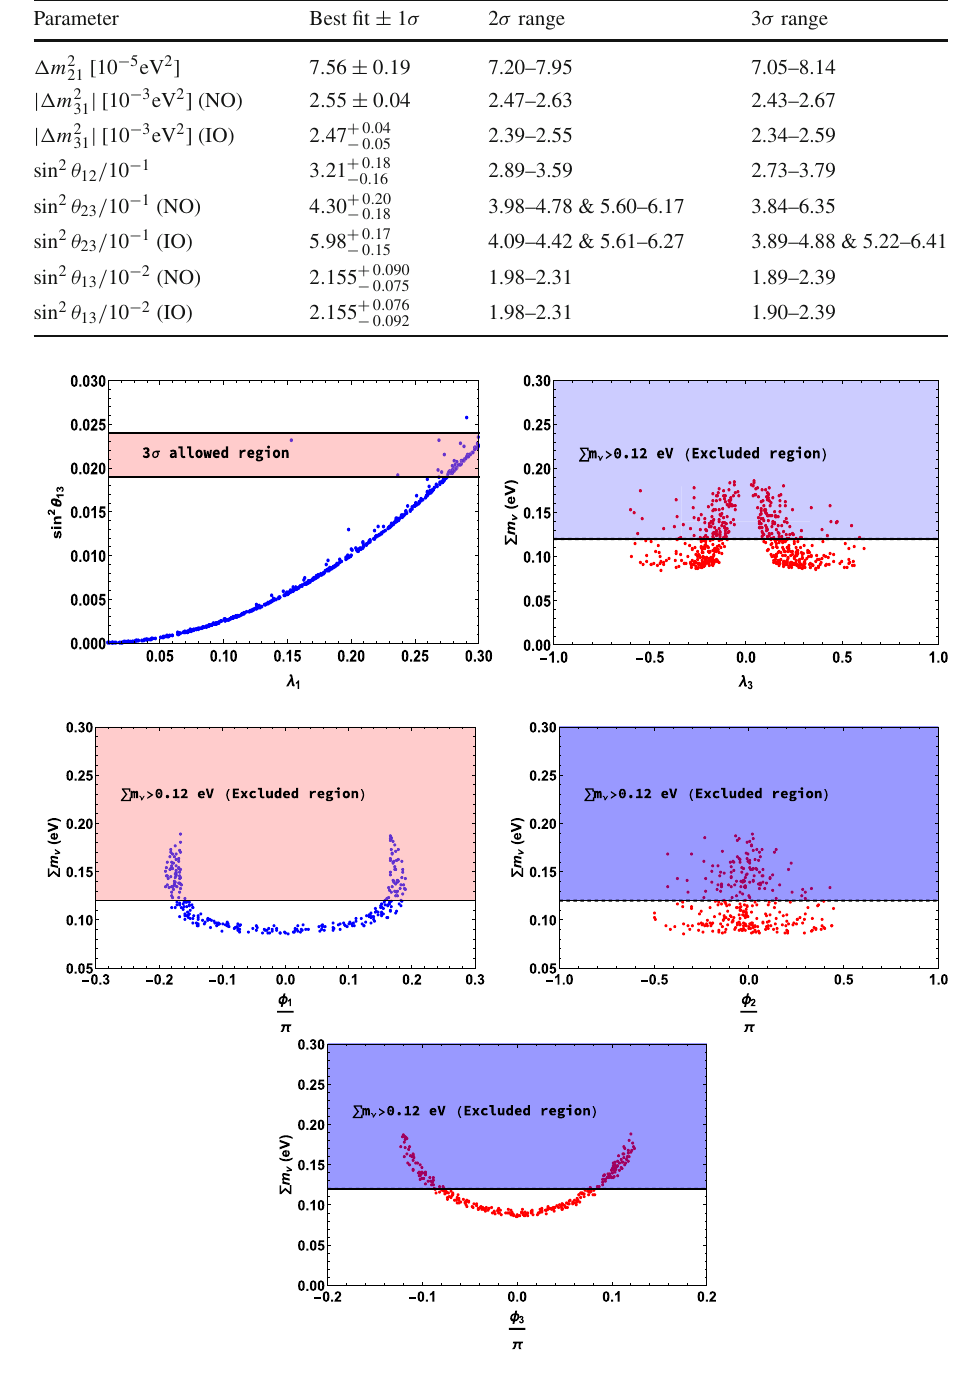
values of Neutrino oscillation parameters for 1 σ , 2 σ and 3 σ range [83,84]